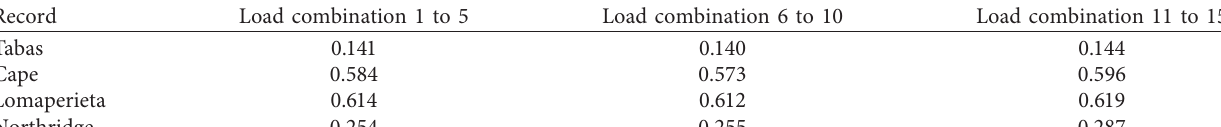
Table 13: Vertical acceleration values at 50% level on tunnel lining in g.